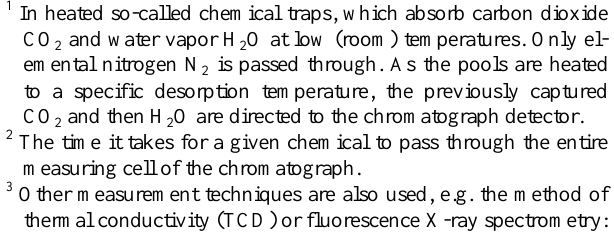
Energy Dispersive X-ray Fluorescence (ED XRF) or Wave- length Dispersive X-ray Fluorescence (WD XRF) [6, 12].